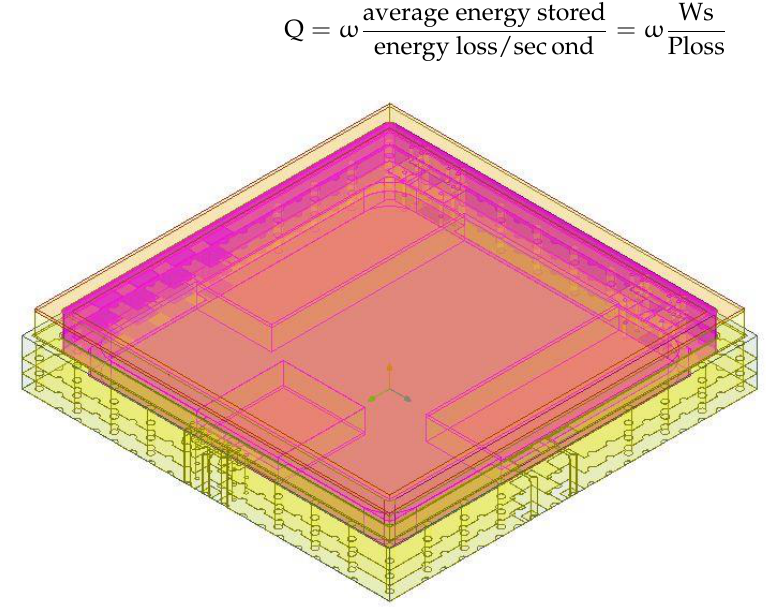
Figure 5. Cavity simulation model of the four-channel Ku-band transceiver SIP. Table 1. The simulated frequency and Q factors of the resonant modes inside the cavity. Resonant